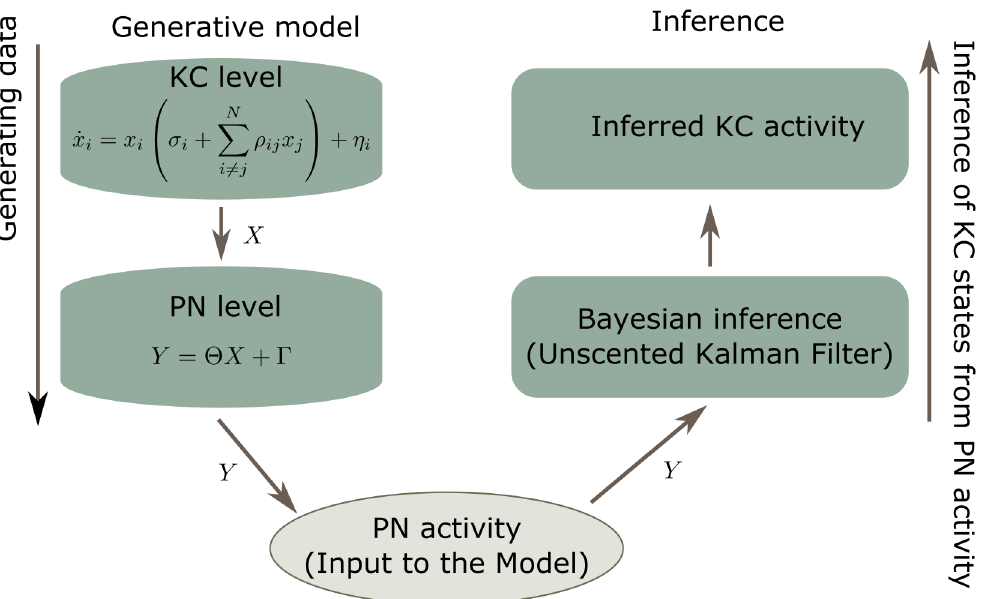
Fig 4. Diagram of the proposed model. The generative model was used in two ways: first, to generate the PN data that was used as input to the Bayesian inference; Second, to describe the internally expected dynamics of the PN and KC populations. Top left: Specifically, the generative model uses the Lotka- Volterra equations to generate activity of the KC population. Bottom left: This activity was projected into the PN population via Eq 2 giving synthetic PN activity that was used as input to the Bayesian inference. Bottom right: Through the unscented Kalman filter, the PN activity observed was balanced with the expected dynamics of the KCs (prescribed by the generative model). Top right: This enabled the model to infer KC activity that is consistent with the PN input data.